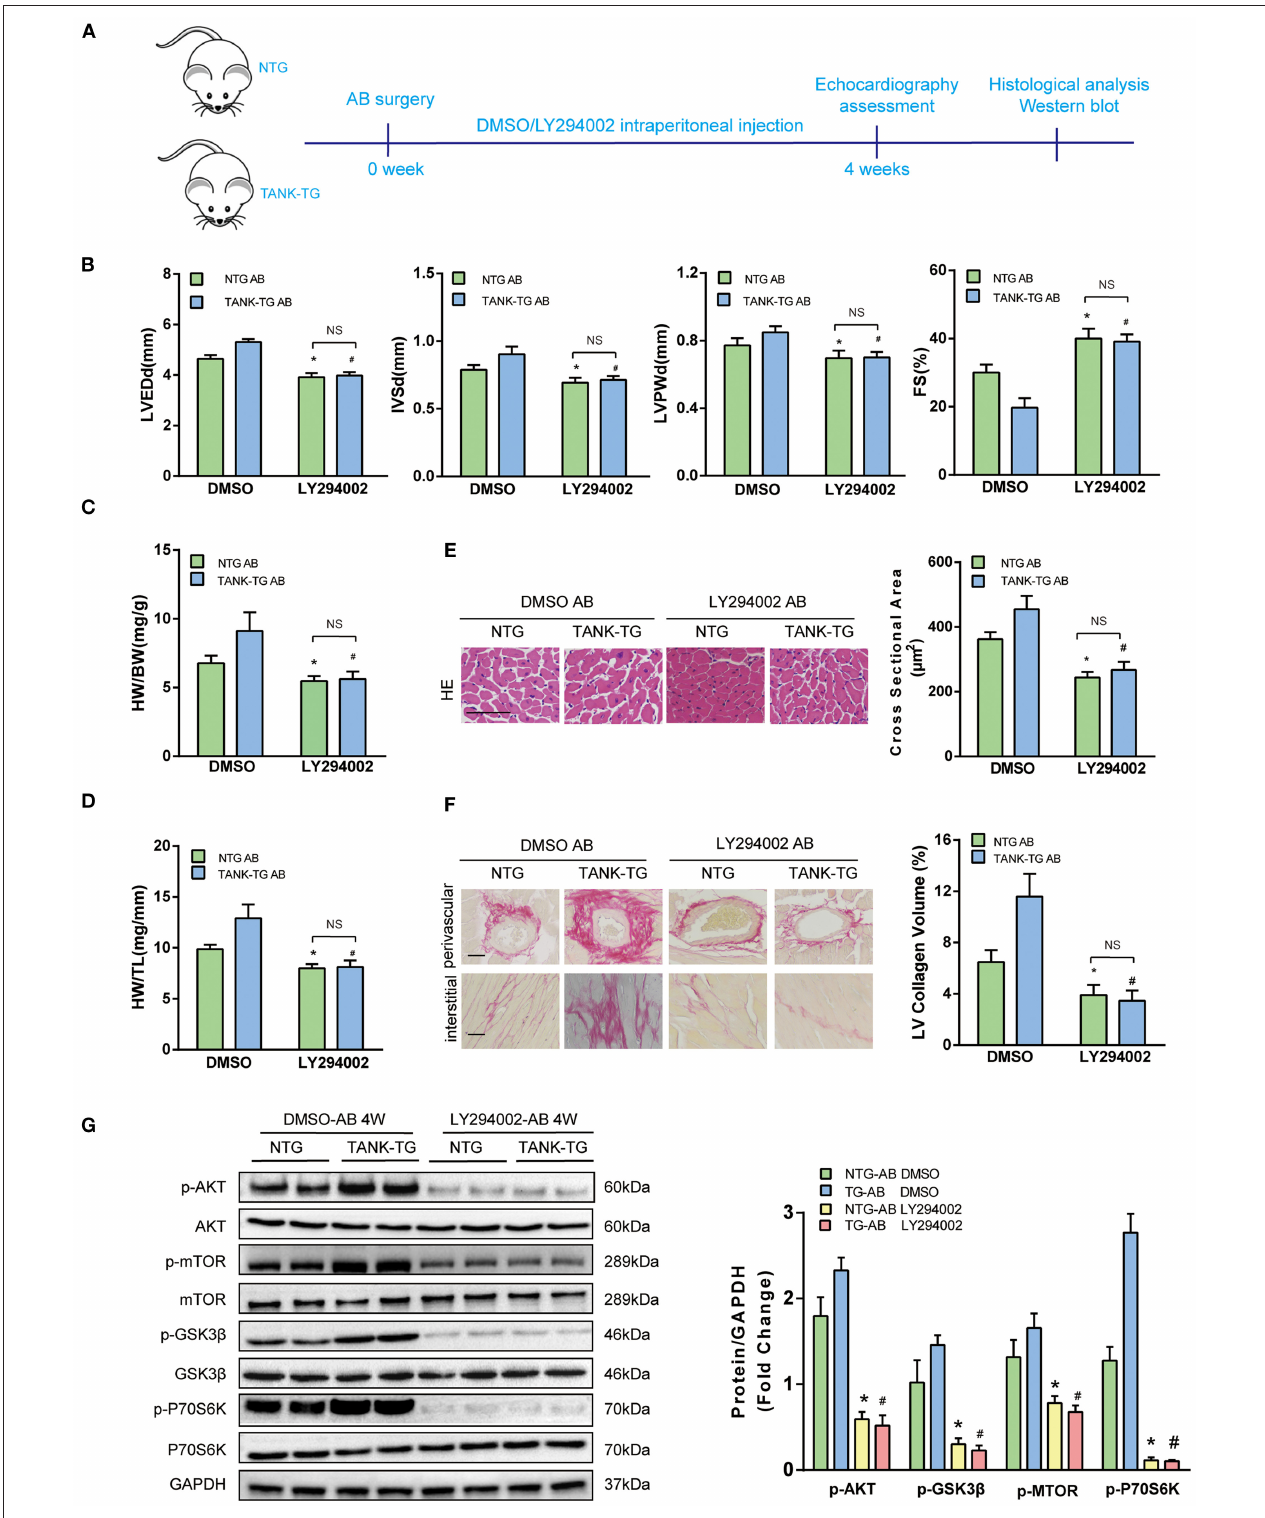
FIGURE 7 | Effect of PI3K inhibitor LY294002 on cardiac hypertrophy in TANK-TG mice. (A) A flowchart to illustrate animal experiments. (B) Echographic parameters obtained from heart samples of the NTG and TANK-TG mice injected with DMSO or LY294002 after aortic banding for four weeks ( n = 4 mice per